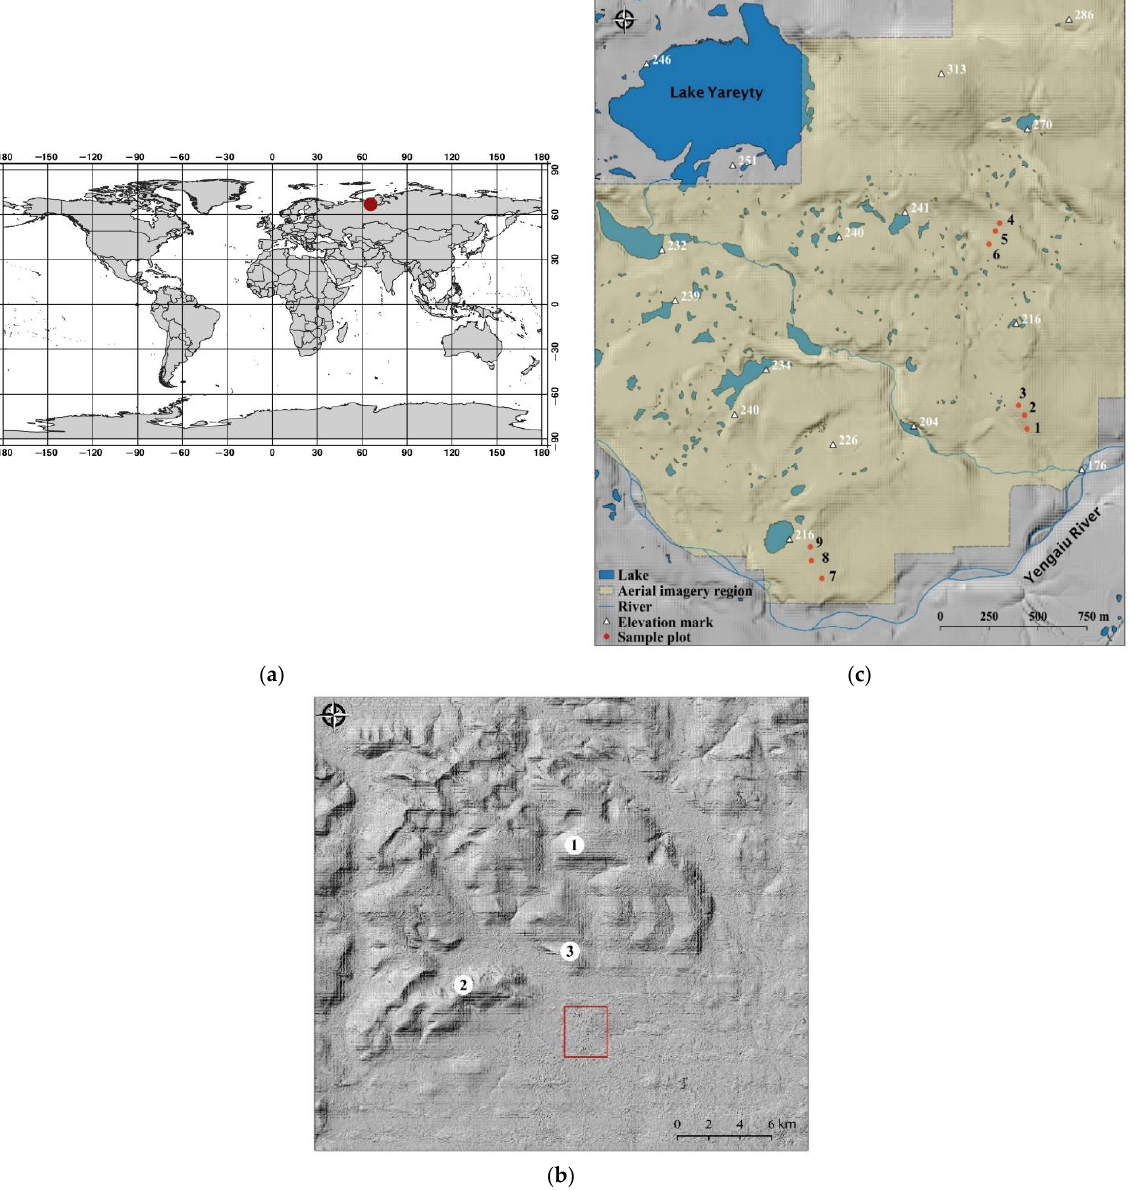
Figure 1. Study area location on the world map ( a ) and on the map of the Rai-Iz massif ( b ): 1—Rai-Iz massif, 2—Chernaya Mountain, and 3—Malaya Chernaya Mountain; shaded relief of the study region with sample plots, area of aerial imagery, hydrographic objects, and elevation benchmarks ( c ).